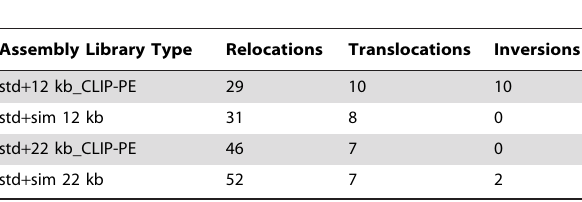
Table 4. Mis-assembly numbers of Saccharomyces cerevisiae CLIP-PE